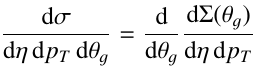
angular exponent β . While z cut sets the energy scale below which soft branches are removed from the